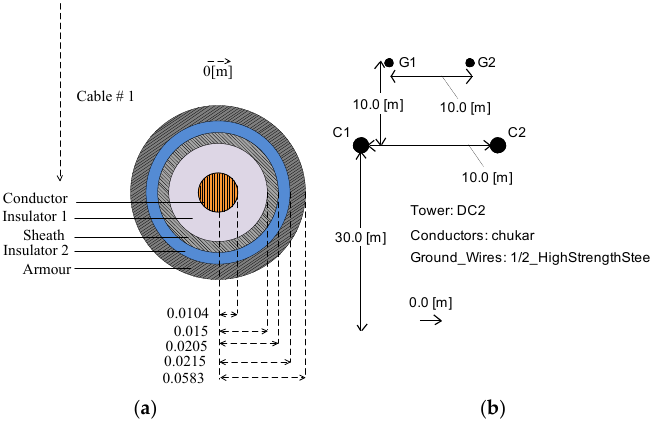
Figure 6. Parameters of HVDC transmission line: ( a ) cables and ( b ) overhead lines.